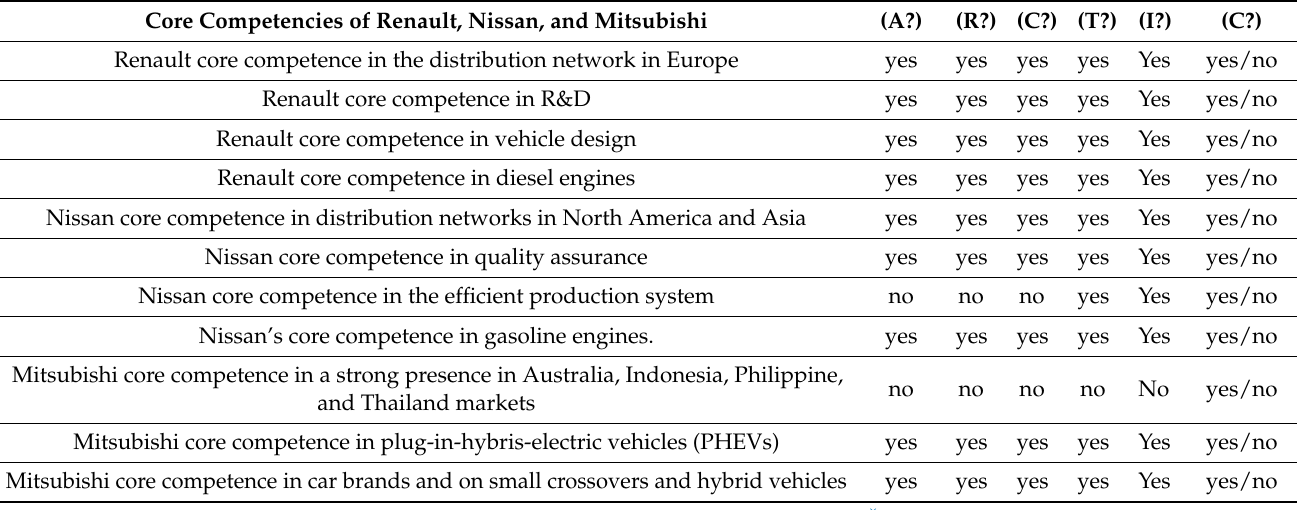
Table 1. The ARCTIC framework: analysis of complementarity, compatibility, and transferability of core competencies of Renault–Nissan–Mitsubishi strategic alliance partners as prerequisites of competence-based synergy. Core Competencies of Renault, Nissan, and Mitsubishi Renault core competence in the distribution network in